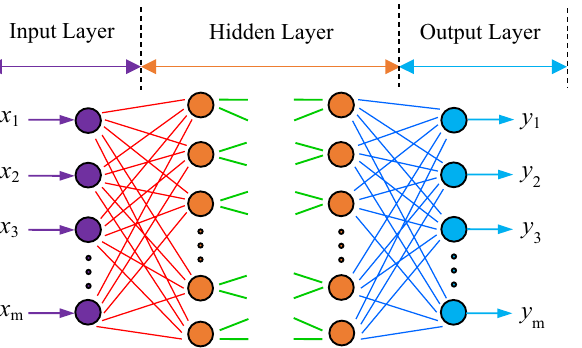
Figure 1. Typical architecture of BP neural network (MS Office 2019; www. micro soft. com/ en- us/ micro soft- 365/ get- start ed- with- office- 2019).